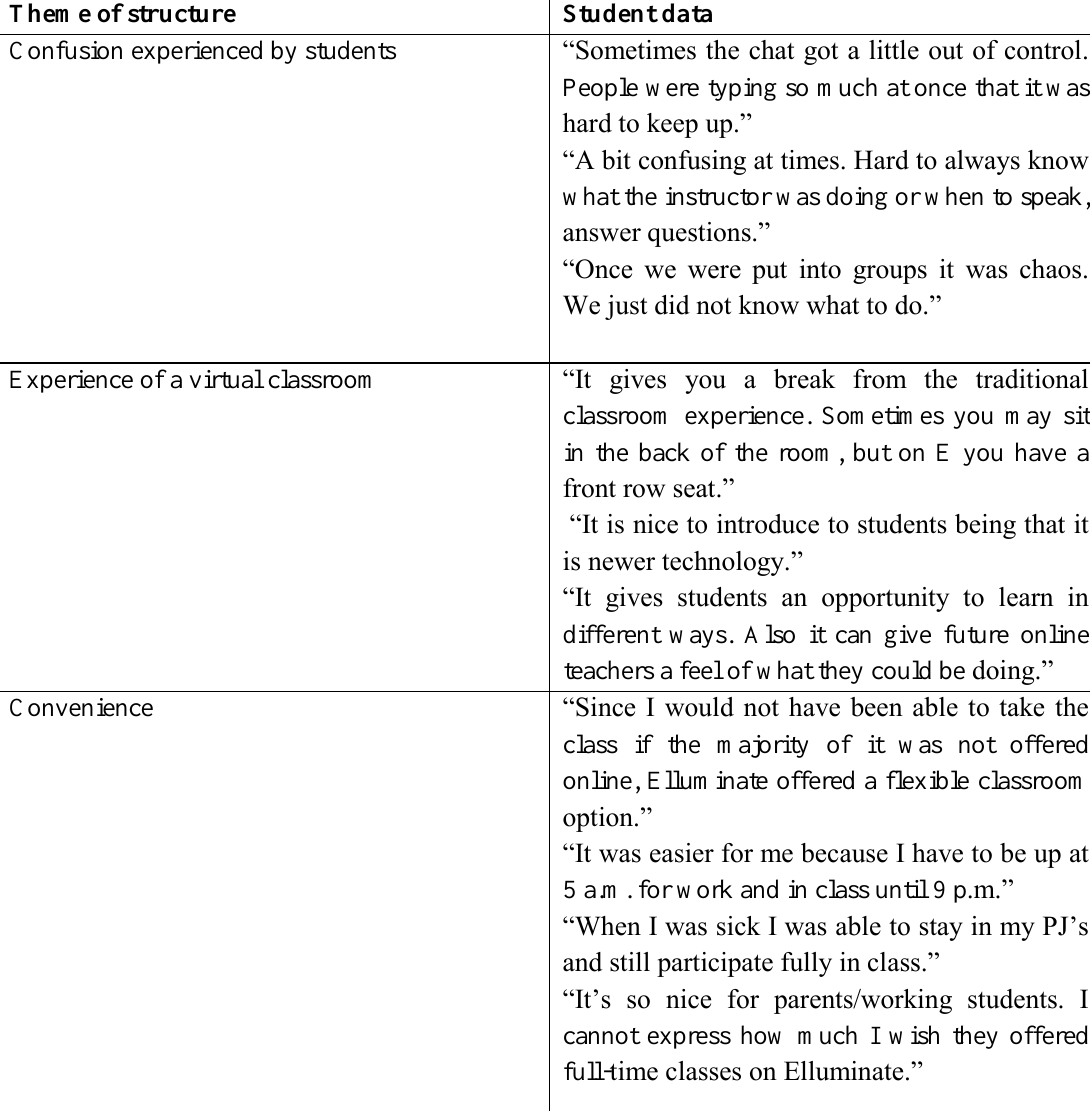
Example of Student Data for Theme of Structure Theme of